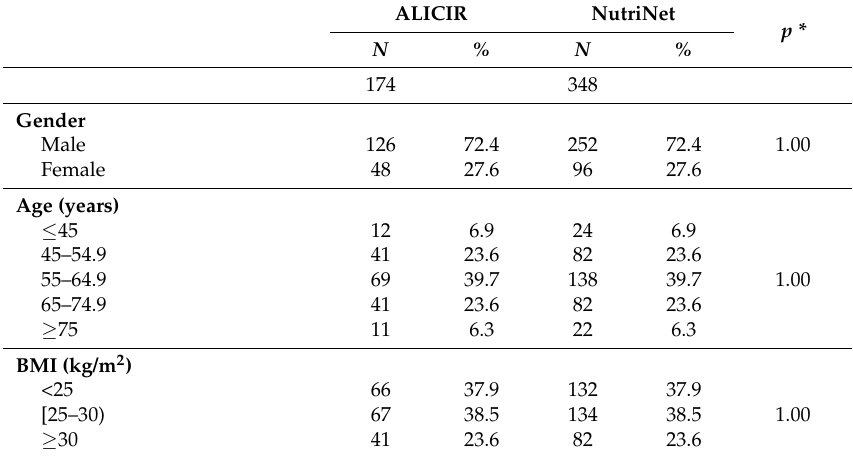
Table 1. Comparison of sociodemographic characteristics for cases and controls ( N =